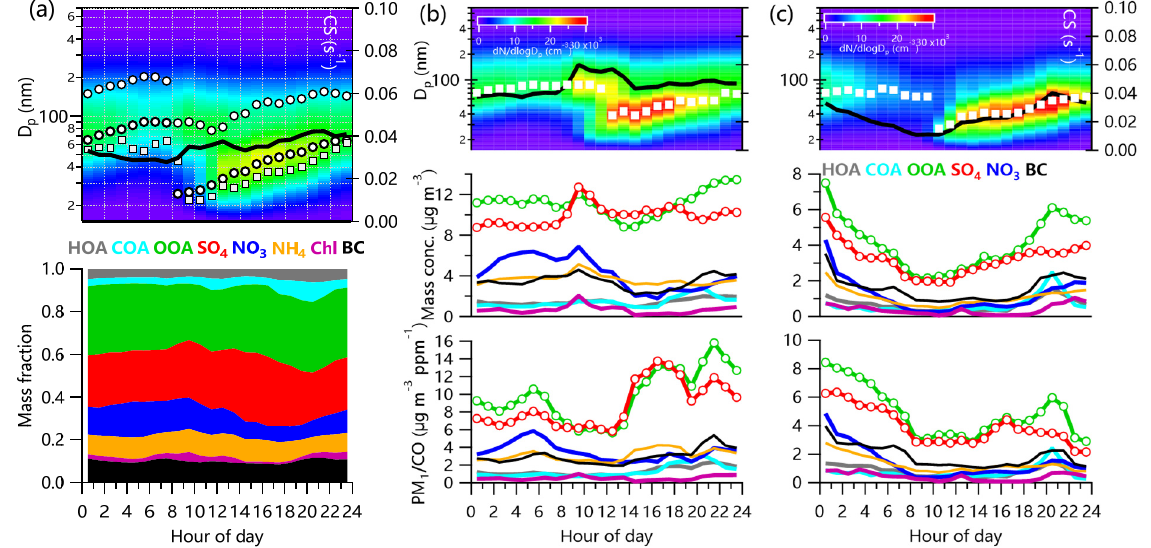
Figure 9. Average diurnal evolution of particle number size distributions and aerosol composition for new particle growth events during (a) the entire study, (b) polluted events, and (c) clean periods. The black solid lines in the top three panels show the diurnal cycles of CS. The circles and squares show the GMD from the log-normal fitting from this study and in Beijing (Du et al., 2017), respectively. The average diurnal cycles of aerosol species and CO-normalized aerosol species during polluted events and clean periods are shown in (b) and (c)